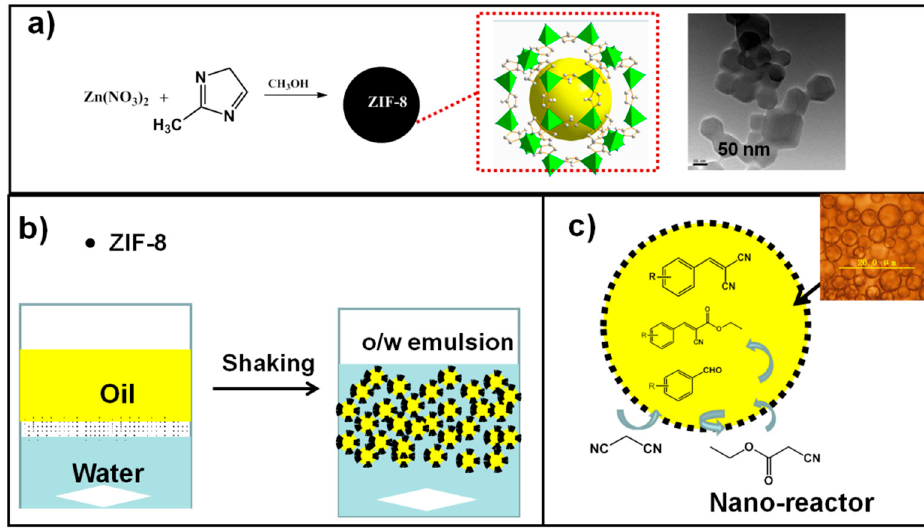
Figure 1. Schematic presentation of the synthesis of ZIF-8 nanoparticles and catalytic reactions in the Pickering emulsion. ( a ) Synthesis and TEM image of ZIF-8 nanoparticles; ( b ) Formation of Pickering emulsion stabilized by ZIF-8; ( c ) Schematic presentation of the Knoevenagel condensation in Pickering emulsion